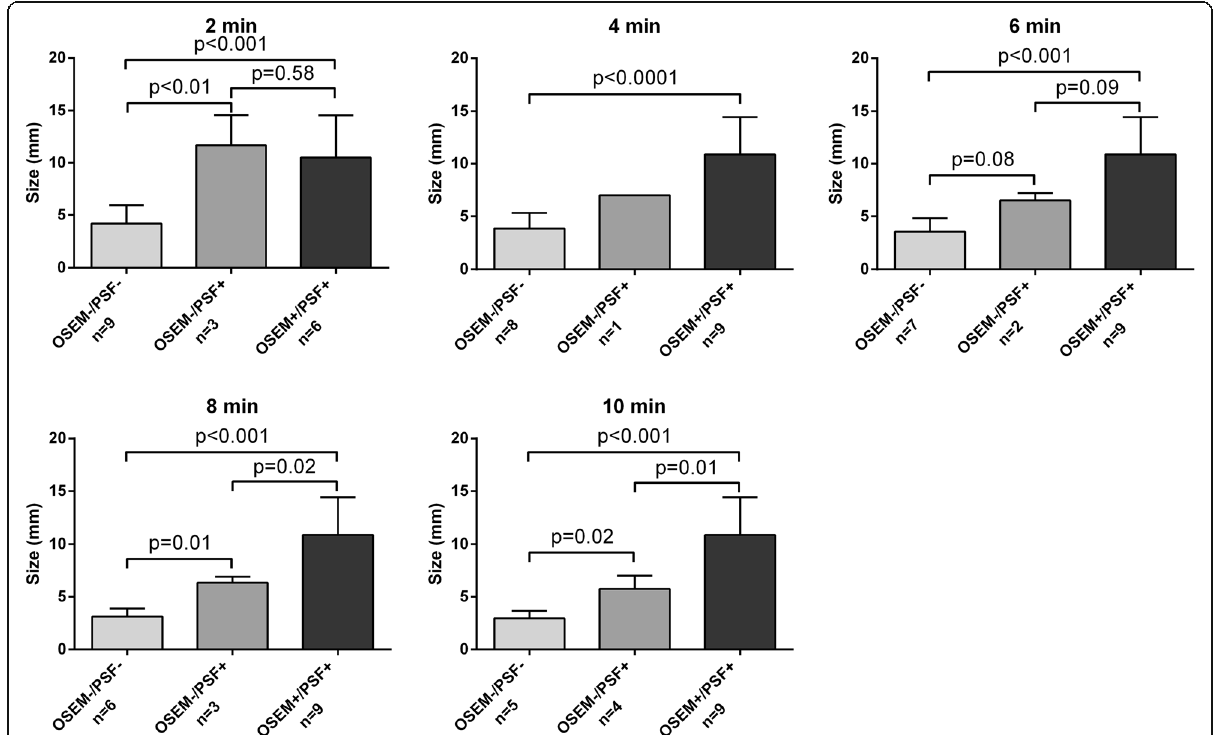
Fig. 7 Comparison of the size (mean, SD) of the lymph node metastases detected or not on the 18 FDG PET/CT scans at each acquisition duration time from 2 to 10 min depending on the reconstruction modality in surgical patients. OSEM-/PSF- are lesions not detected by either reconstruction, OSEM-/ PSF+ are those detected only by PSF allpass reconstruction, and OSEM+/PSF+ are those detected by both